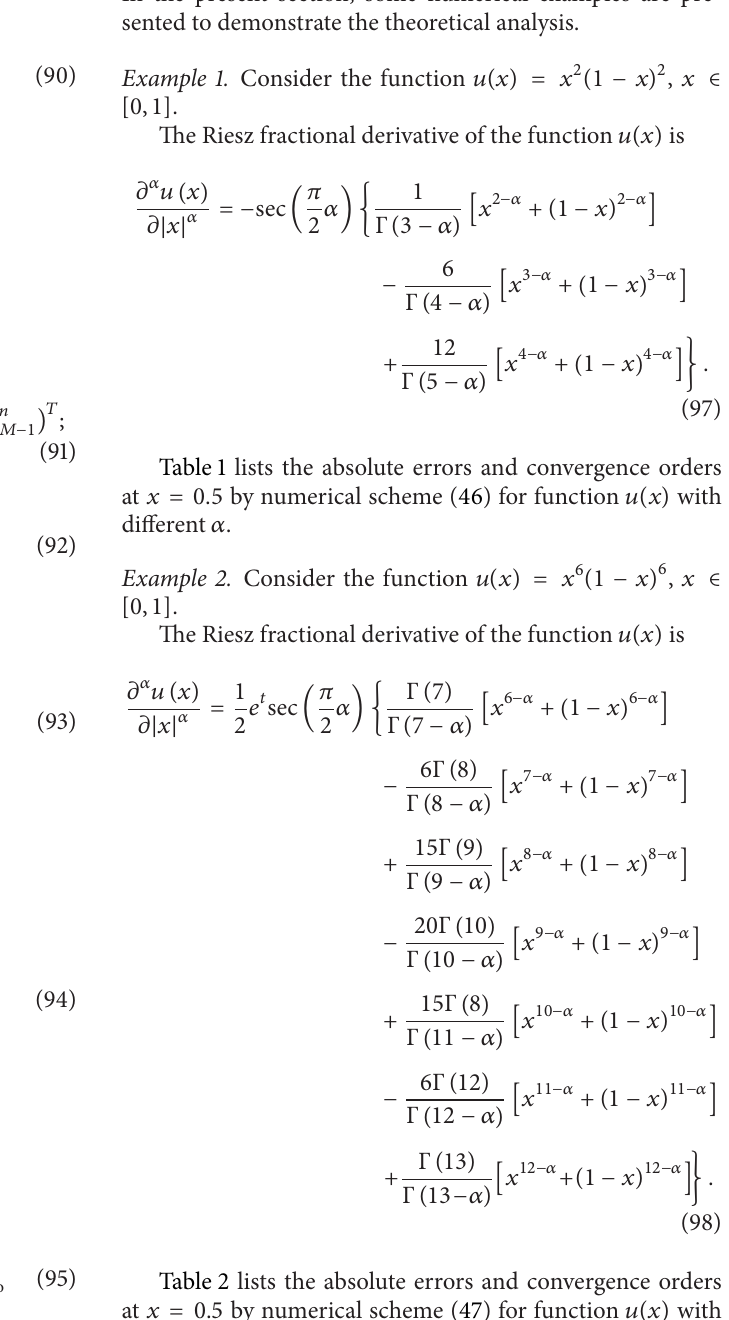
at 𝑥 = 0.5 by numerical scheme (47) for function 𝑢(𝑥) with different 𝛼 . These computational results confirm the second- order and fourth-order of the numerical formulas (46) and (47),